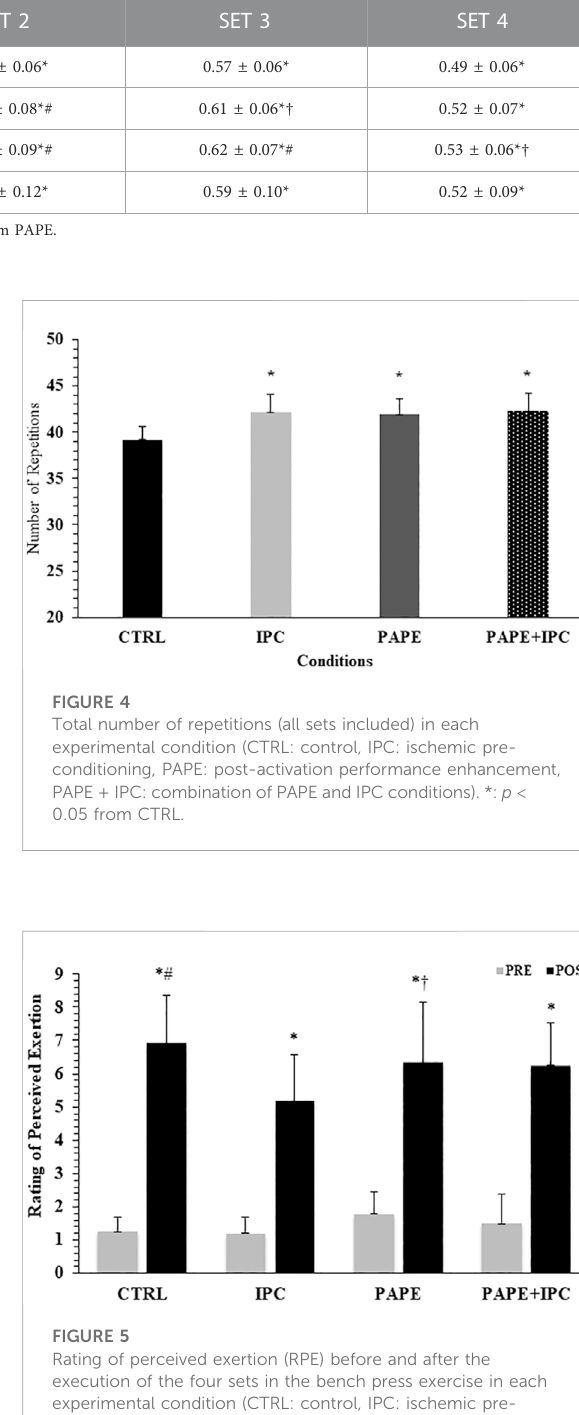
conditions). *: p < 0.05 from PRE, # and † : p < 0.01 and p < 0.05 from IPC.